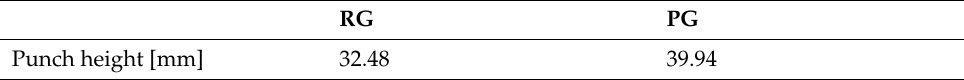
Table 5. Punch height measured after the deep drawing process.